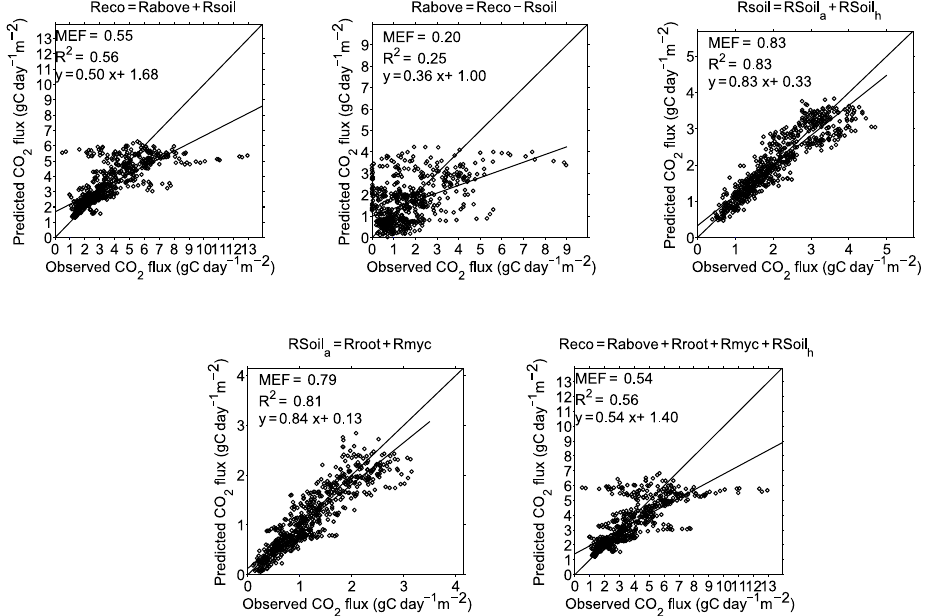
Figure 10. Observed versus predicted R eco component fluxes, where predicted values are computed as derived fluxes based on the GEP models given in Eqs. (22)–(28) that were trained on 500 data points (d.p.) of daily mean values of various R eco components.